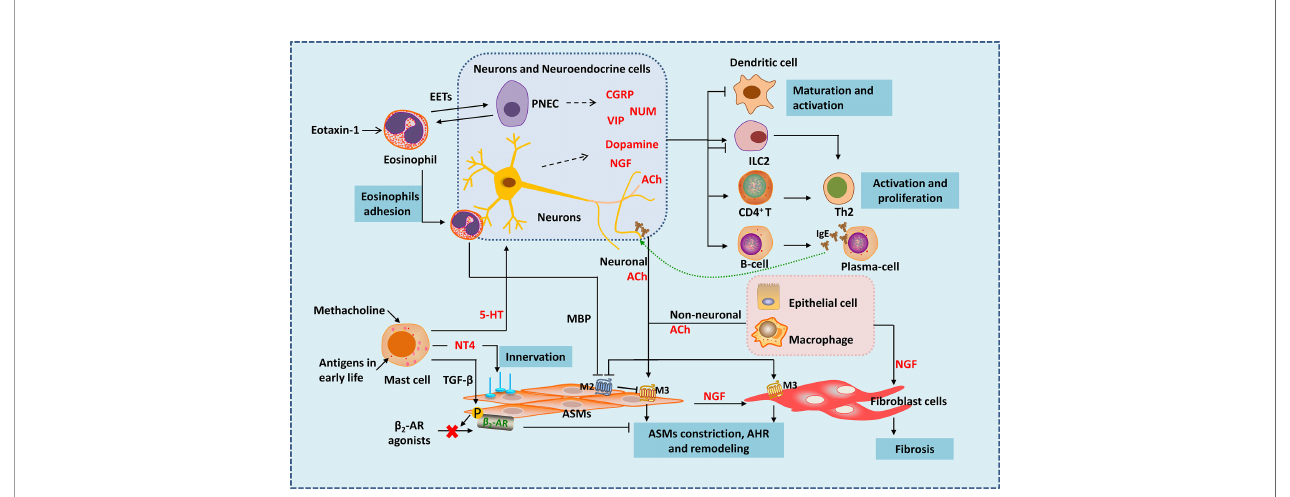
FIGURE 1 | Neuro-immune interactions in in fl ammation and airway remodeling of allergic asthma. Eosinophils migrate to airway during in fl ammation via eotaxin-1. They release EETs surrounding and activating PNECs. Under the action of VLA-4 and CD11b, eosinophils adhere to VCAM-1 and ICAM-1 on parasympathetic fi bers. Eosinophils are then activated and release MBP, which is an antagonist of M2 muscarinic receptor, thus enhancing parasympathetic mediated bronchoconstriction. Besides, eosinophils increase airway innervation. Under the stimulation of methacholine, mast cells release 5-HT, interacting with 5-HT 2 receptors in parasympathetic nerves, thus release ACh (neuronal ACh), enhancing bronchoconstriction. Mast cells also produce NT4 following allergen exposure during early-life, increasing ASMs innervation through NT4/TrkB signaling, causing long-term airway dysfunction. Mast cells also produce TGF- b to induce b 2-AR phosphorylation in ASMs, thereby causing b 2-AR agonists resistance. Neuropeptides generate form neurons and neuroendocrine cells such as NMU and VIP activate ILC2s. CGRP generated mainly from PNECs inhibits maturation of DCs, it may have bidirectional effects on ILC2s. Besides neuronal ACh, non-neuronal ACh released from epithelia cells and macrophages mainly acted in small airways. ACh activate muscarinic 3 acetylcholine receptor on ASMs and fi broblast cells, causing airway contraction and airway remodeling. NGF released from neurons, epithelial cells, ASMs and other immune cells acts on fi broblasts leading to fi brosis. NGF can also activate Th2 cells and promote the differentiation of B cells into plasma cells. EETS, Eosinophil extracellular traps; PNEC, pulmonary neuroendocrine cell; MBP, major basic protein; 5-HT, 5-hydroxytryptamine; ACh, acetylcholine; NT4, neurotrophin 4; ASMs, airway smooth muscle cells; NGF, nerve growth